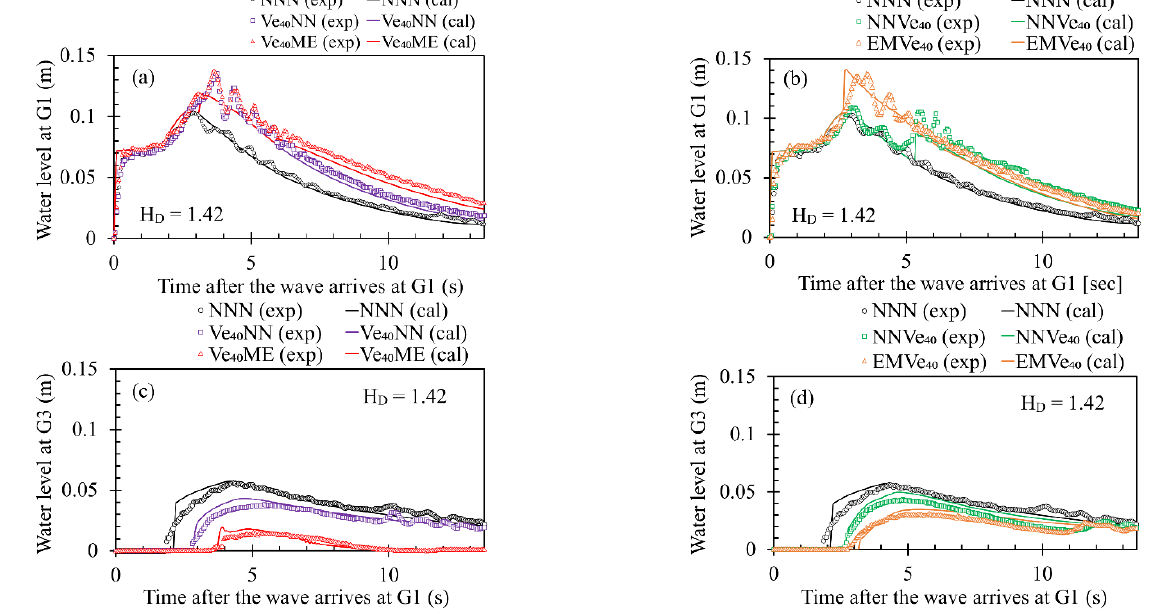
Figure 4. Time series of water levels in experiments (Zaha et al. [10]) and in simulation (this study). ( a ) Seaward vegetation type (G1), ( b ) landward vegetation type (G1), ( c ) seaward vegetation type (G3), and ( d ) landward vegetation type (G3).